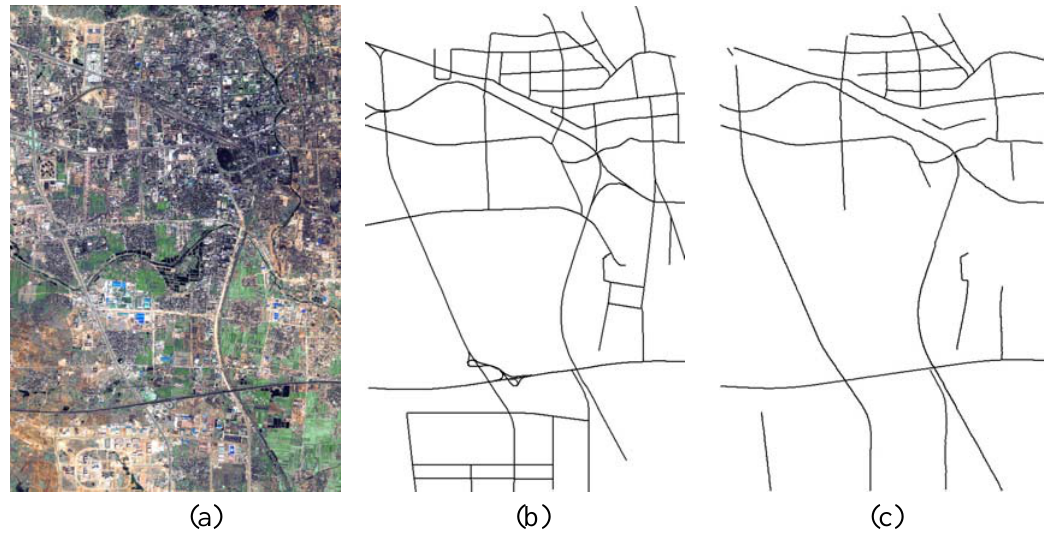
Figure 4. Road network extraction from an IKONOS satellite image. (a) IKONOS fused image with 1 m pixel -1 resolution and 9,374 pixels by 6,246 pixels image size; (b) the reference road network plotted; (c) the vector road network extracted by the combination strategy.